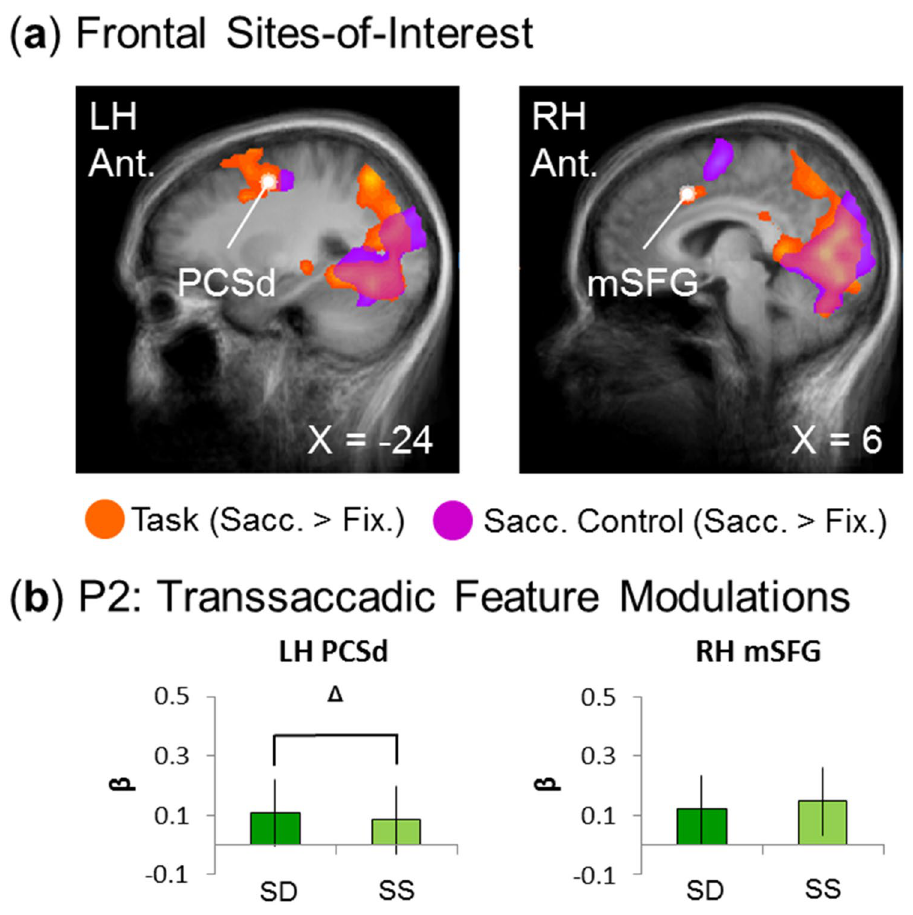
Figure 4. Testing feature sensitivity in frontal sites-of-interest. ( a ) The sites-of-interest in frontal cortex were localized and are visualized on the slices of the averaged brains of all (n = 15) participants. (These regions are superimposed onto activation maps from an RFX GLM for the experimental transsaccadic data (n = 15; orange) and from the separate saccade control task (n = 12; fuchsia) (BrainVoyager QX v2.8; www. brain voyag er. com). The white dots represent peak voxels of each frontal site-of-interest. The left panel shows the left dorsal precentral sulcus (PCSd) and the right panel shows the right medial superior frontal gyrus (mSFG). ( b ) We tested feature sensitivity in frontal regions, though with no particular directional hypothesis, for spatial frequency (experimental task data; n = 15). Results indicate that there is a trend toward statistical significance ( p < 0.10) for feature sensitivity in left PCSd, with no effect in right mSFG. Overall, this supports a more general saccade-related role for frontal regions in transsaccadic tasks, like this one. Bar graphs show mean β-weights ± SEM analyzed using two-tailed repeated measures